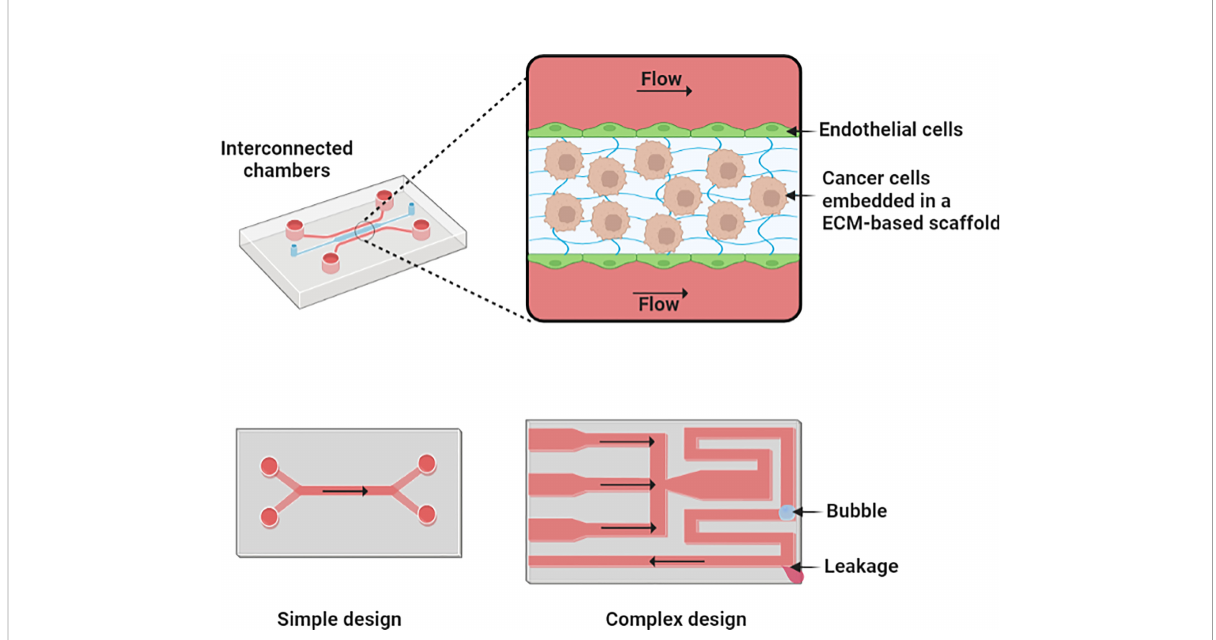
FIGURE 6 An illustration of micro fl uidic culture models. Micro fl uidic devices comprise the interconnection of chambers and grooves sharing low volumes of liquids. A more complex design with more channels and chambers can enhance its physiological representation but may also increase the chance of challenges as bubble blocking and liquid leakage. Figure created with